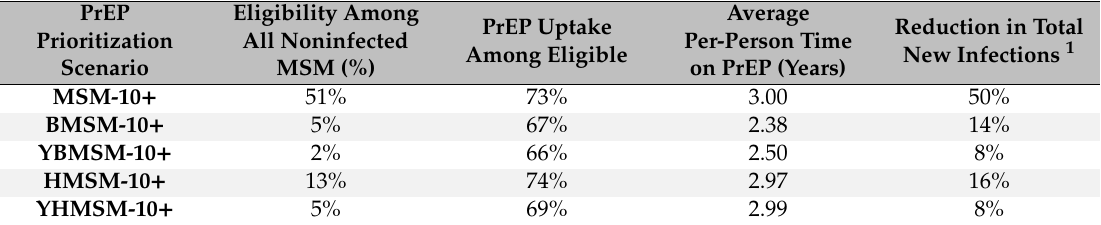
Table 3. Percentage of MSM eligible for PrEP under each prioritization scenario, and percentage of uptake and average time on PrEP within each target group in